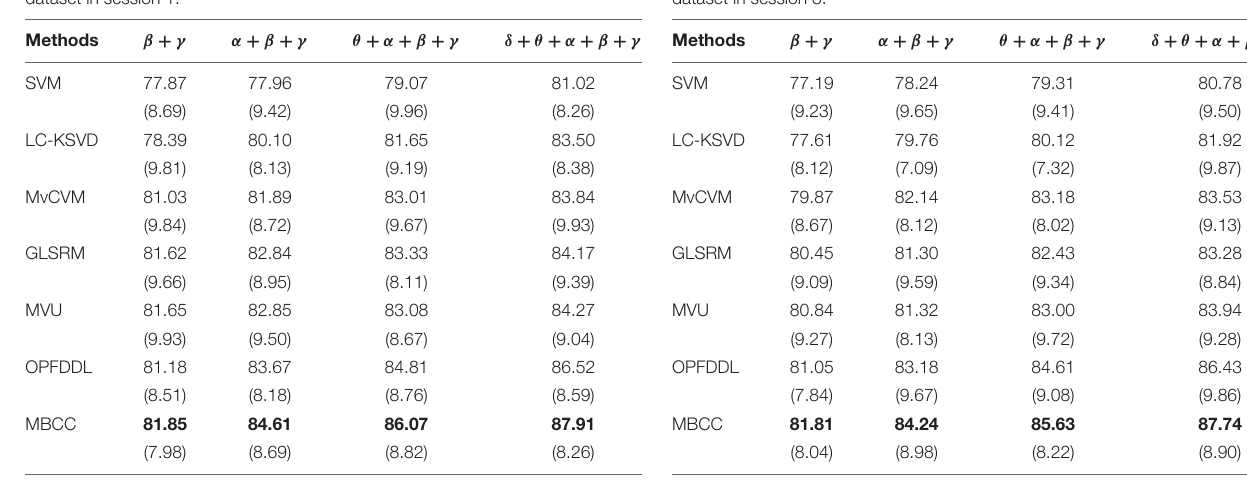
The best performance of each comparison is emphasized by the bold